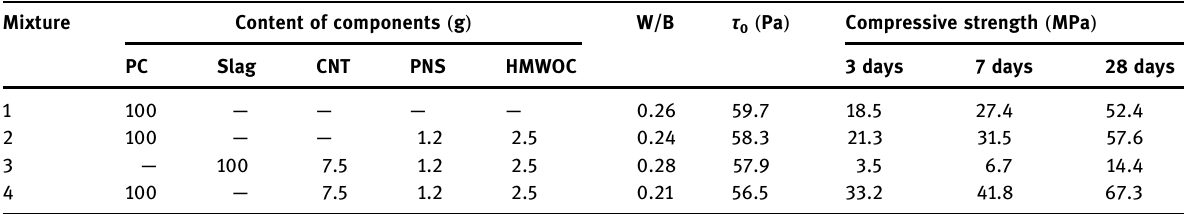
Table 8: Composition and properties of cement pastes with CNT nano - modi fi er